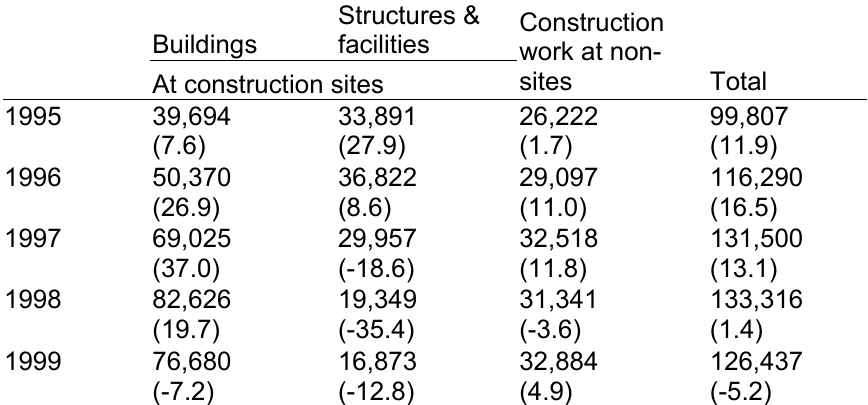
Table 1. Gross value of construction works by main contractors